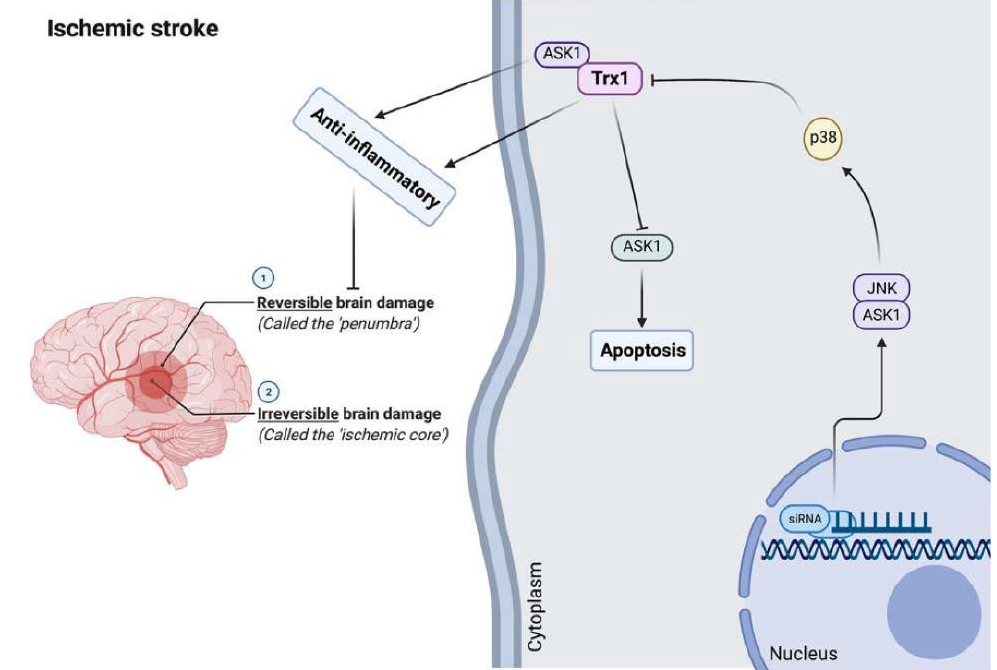
Figure 5. The role of Trx1 in the pathophysiology of ischemic stroke. Trx1 participates in the pathophysiology of brain stroke. Although Trx1 could directly combine with ASK1 to decrease its activity, TXNIP may inhibit Trx1 activity from inducing brain ischemic stroke under oxidative stress conditions. Inhibition of Trx1 with siRNA induces neuronal apoptosis by stimulating the brain ASK1-JNK/p38 signaling pathway.Trx: thioredoxin; TXNIP: Trx1 interacting protein; ASK1: apoptosis signal-regulating kinase 1.